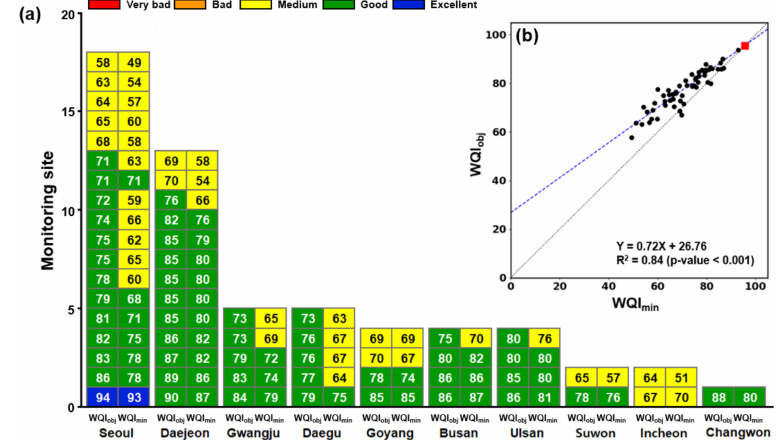
Figure 5. Spatial distribution of the water quality index (WQI) in ten major metropolitan areas of South Korea. ( a ) Mean objective WQI (WQI obj ) and minimum WQI (WQI min ) values and grades from 2015 to 2018 for each of the 58 monitoring sites. ( b ) Relationship between mean WQI obj and WQI min values.